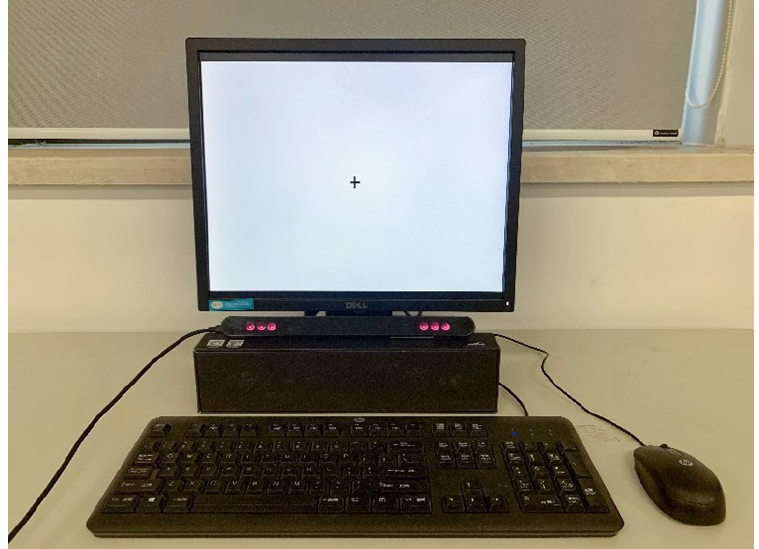
Figure 1. Real-time fatigue detection hardware environment